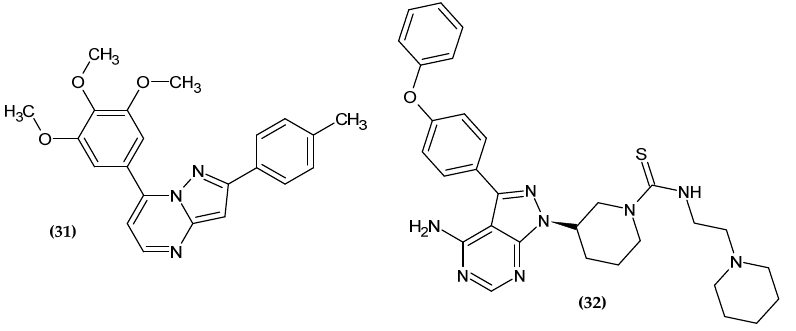
Figure 6 . Pyrazolopirimidine derivatives with anti-melanoma activity. Figure 6. Pyrazolopirimidine derivatives with anti-melanoma